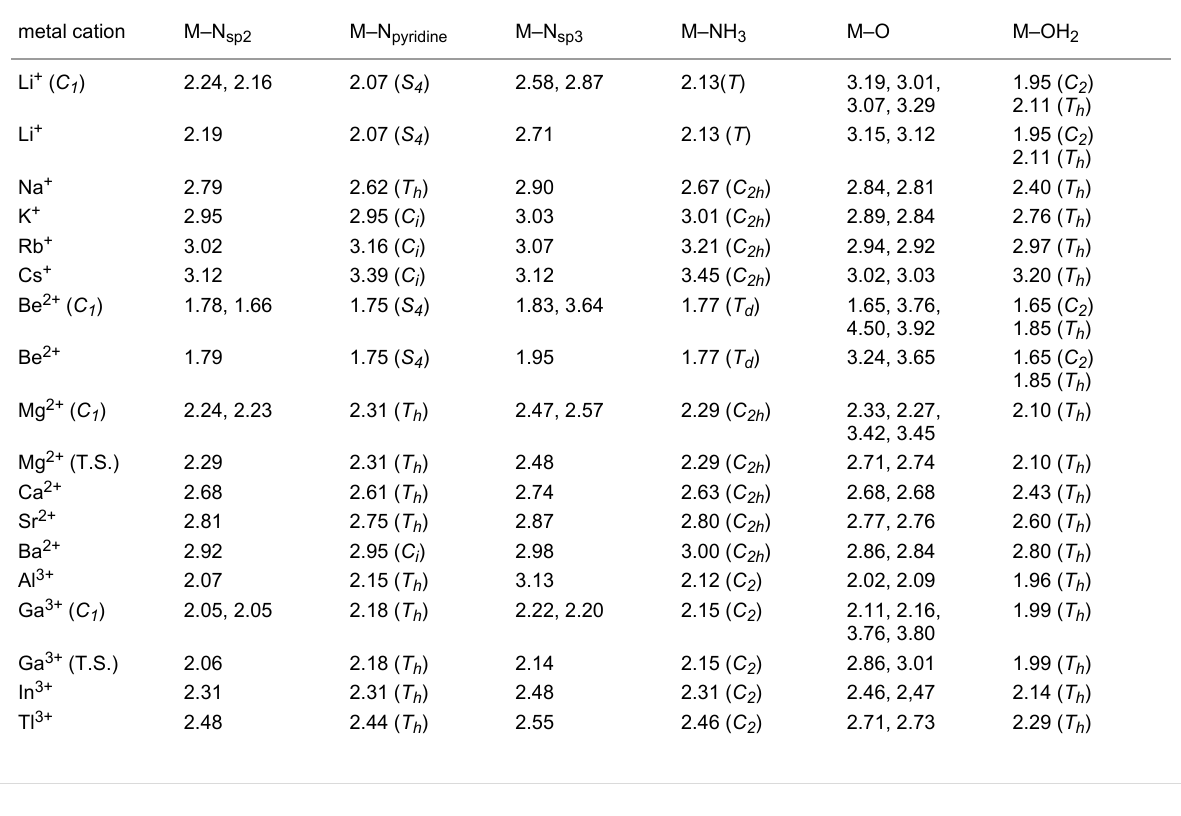
Table 7: Comparison of the calculated distances (in Å) of the metal–donor interactions in [2.2.bpy] with [M(pyridine) n ] m+ , [M(NH 3 ) n ] m+ and [M(H 2 O) n ] m+ (point groups are given in parenthesis, for most metal cations C 2 symmetry is adopted).